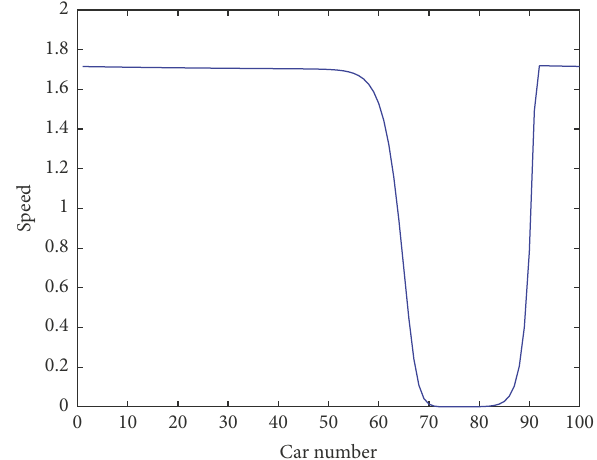
Figure 4: Speed profiles for DSDM with 𝛼 = 0.4 , 𝑇 𝑠 = 0.6 at 𝑡 =